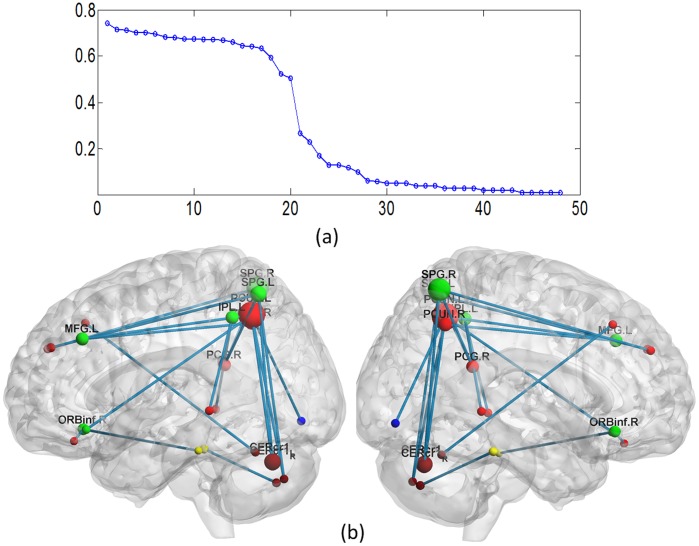
Altered resting-state functional connectivity in ASPD.(a) τ value distribution of all 48 features represented in the LOOCV. The horizontal axis represents each functional connection and the vertical axis represents the weighted Kendall tau correlation coefficient. (b) Region weights and the distribution of the 20 high discriminative power functional connections. Regions are color-coded by category, red sphere represented default mode network, green sphere represented attentional network, brown sphere represented cerebellum.